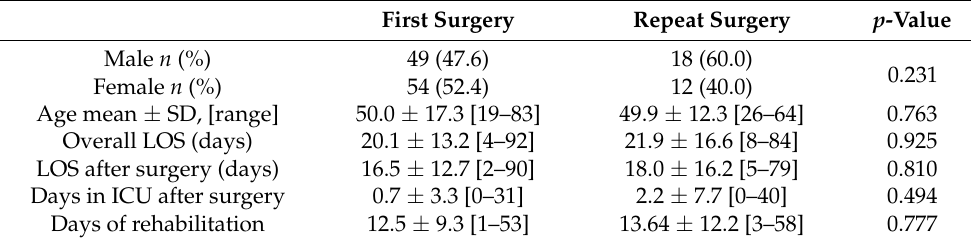
Table 2. Demographic characteristics of the study participants and time parameters of treatment.